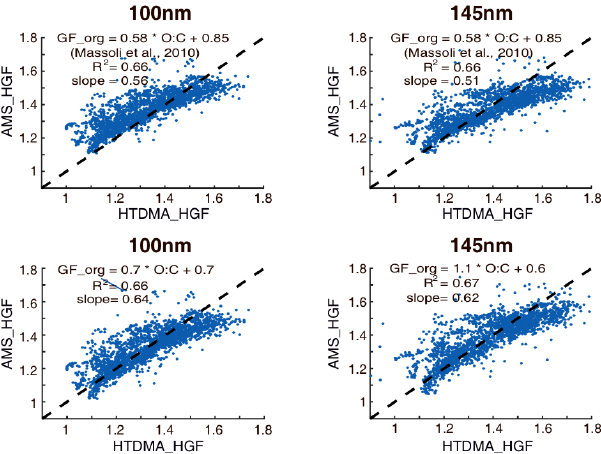
Figure 7. Comparison between AMS-derived HGF with measured HGF when taking into account of both oxidation level and inorganic volume fraction on GF of the organics. The dashed lines indicate the 1 : 1